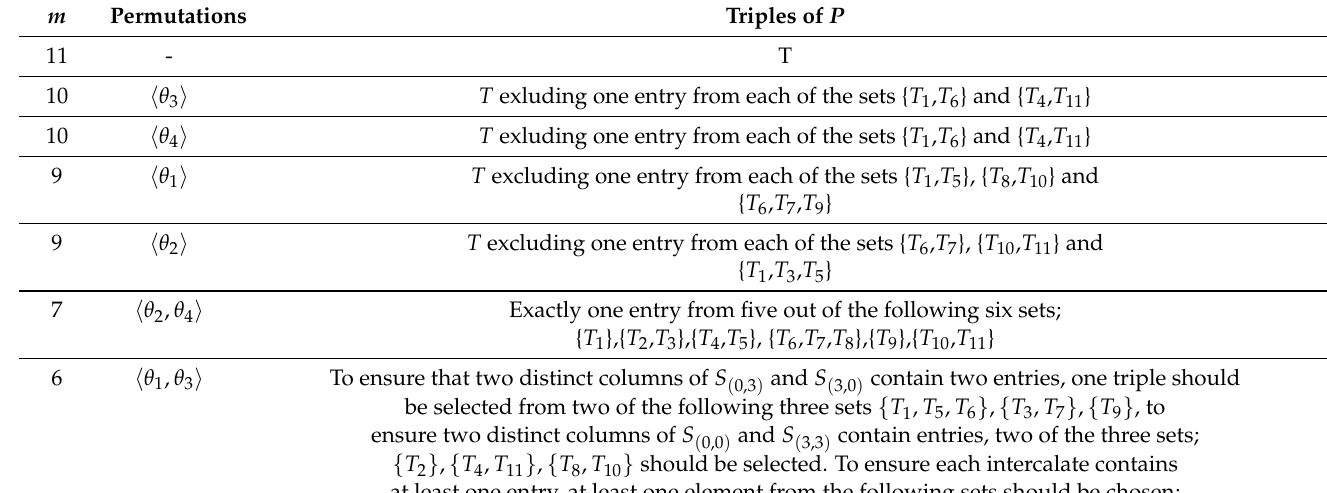
Table A1. Redefined access levels based upon results of this